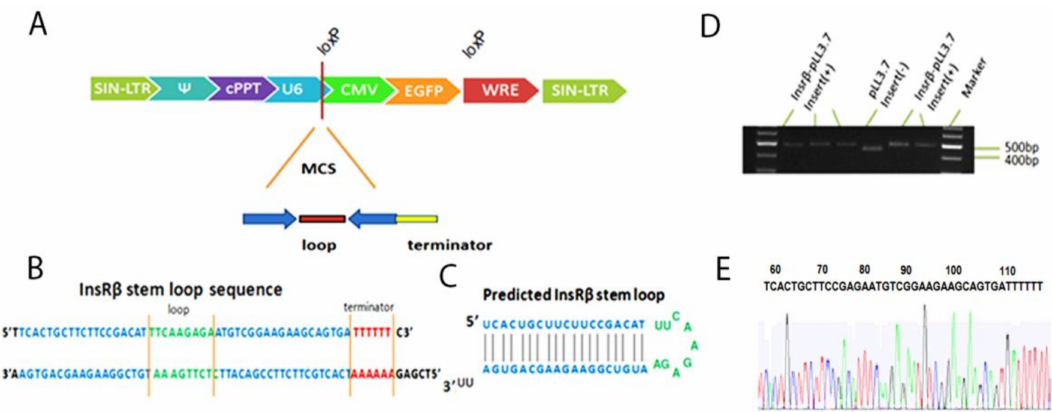
Figure 1. Lentiviral vector and predicted InsR β shRNAs. ( A ) The linear structure of pLL3.7; the shRNA expression cassette is under the control of U6 promoter and eGFP gene is under the CMV promoter. ( B ) The annealed shRNA expression cassette. ( C ) The finished stem-loop structure of a representative shRNA. ( D ) Agarose gel electrophoresis shows a 500 bp band cut from a positive InsR β -pLL3.7 while band cut from pLL3.7 was 450 bp. ( E ) Sequencing results confirms the inserted shRNA-3 sequence is correct.